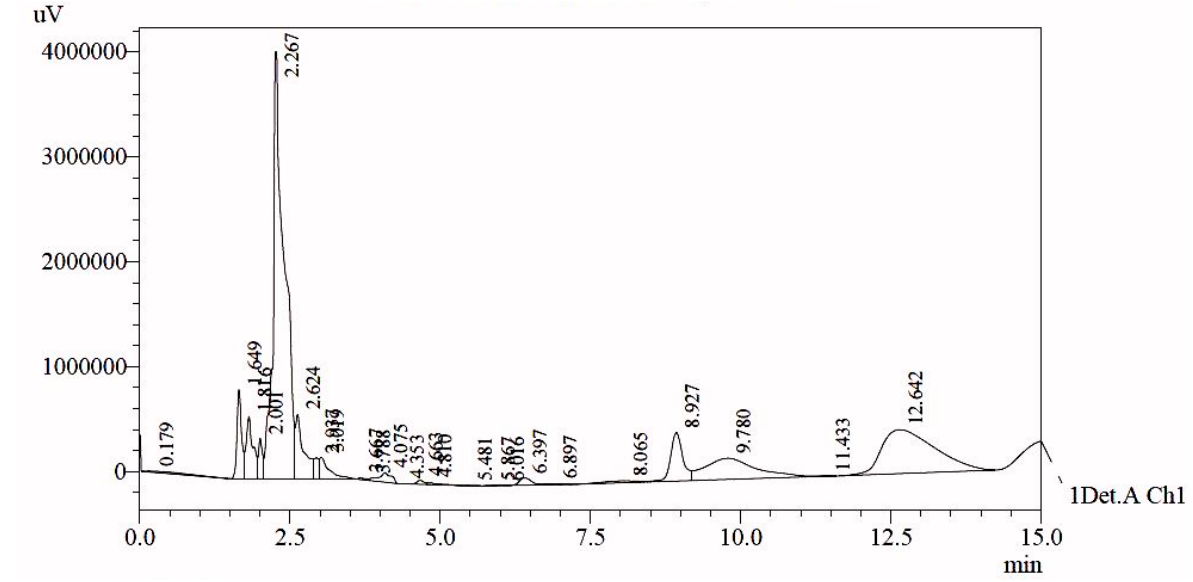
Figure 1. HPLC-UV chromatogram of egg yolk extract. Table 1. HPLC data obtained from egg yolk extract.